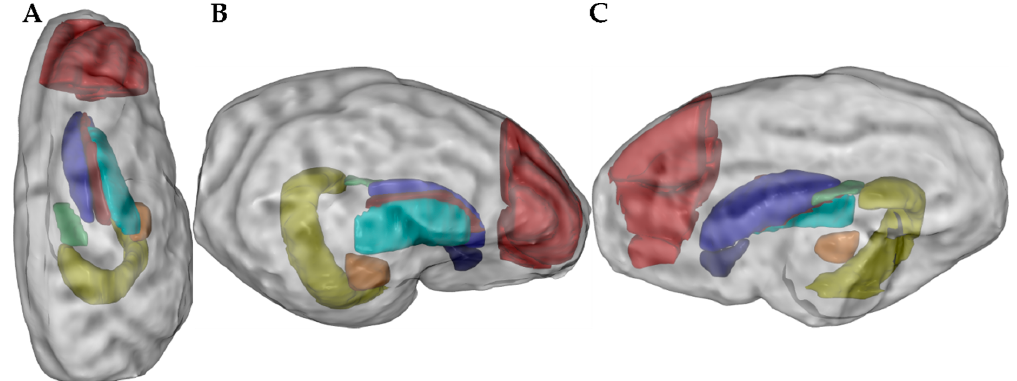
Figure 1. Regions of interest (ROIs) after magnetic resonance imaging presented in top view ( A ), lateral view ( B ), and medial view ( C ), respectively. Measured ROIs: nucleus accumbens (dark blue), caudate nucleus (blue), lentiform nucleus (cyan), fornix (green), hippocampus (yellow), amygdala (orange), prefrontal cortex (red), and internal capsule (burgundy).